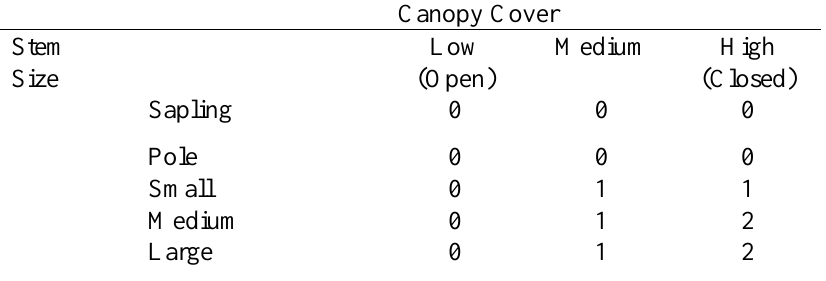
Table A8.1. Habitat quality scores for mixed conifer types: Douglas-fir, Douglas-fir-White fir, white fir, grand fir, and red fir/white